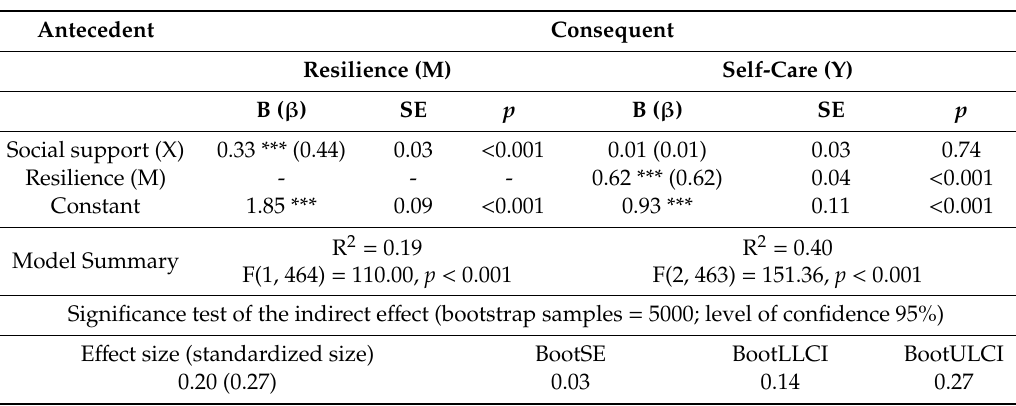
Table 5. Testing of the Mediation Model ( N = 466).